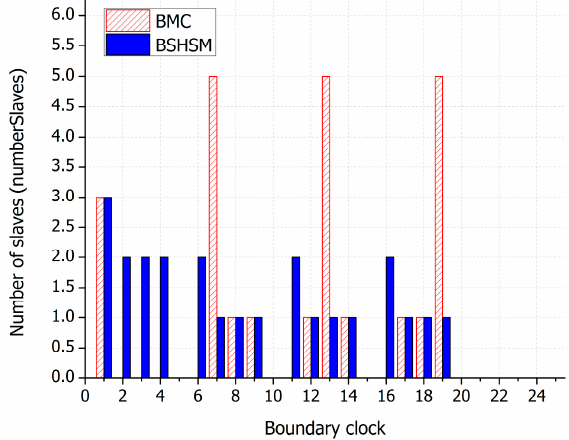
Figure 10. The number of slaves for each BC in simulation 1.